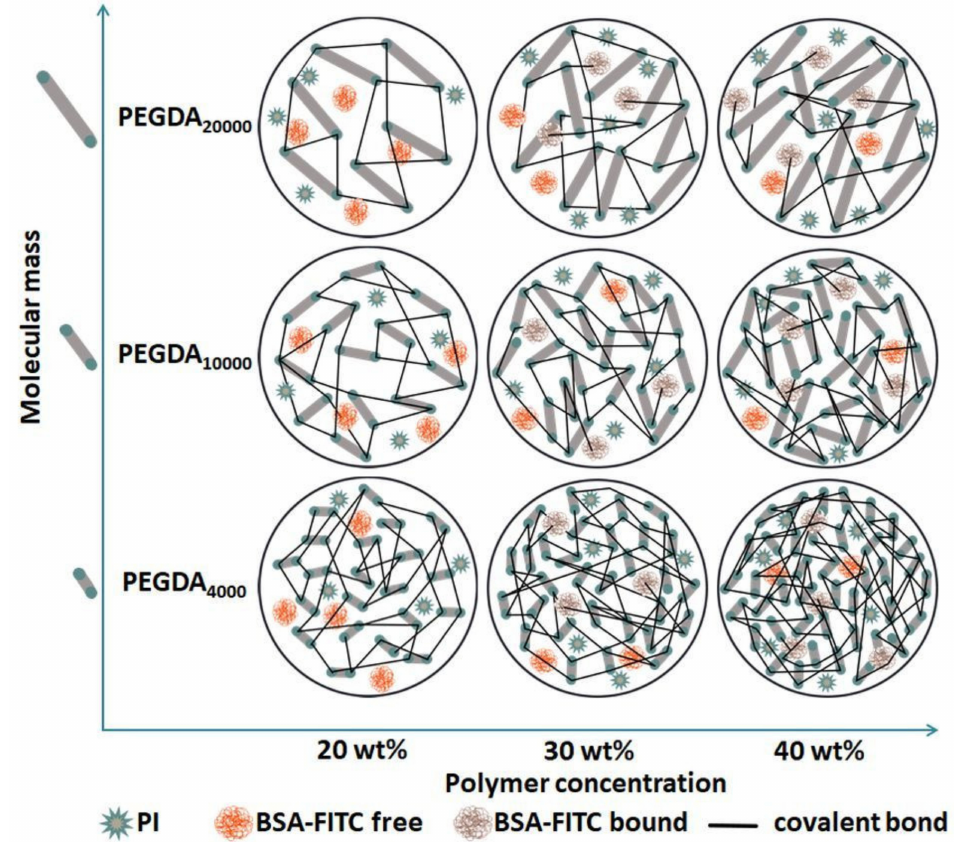
Figure 8. Schematic illustration of hydrogel network formed with the photopolymerization of differently concentrated PEGDA 4000 , PEGDA 10000 , and PEGDA 20000 solutions with PI (stars) and BSA–FITC (balls). PEGDA is represented as sticks connected into longer chains with covalent